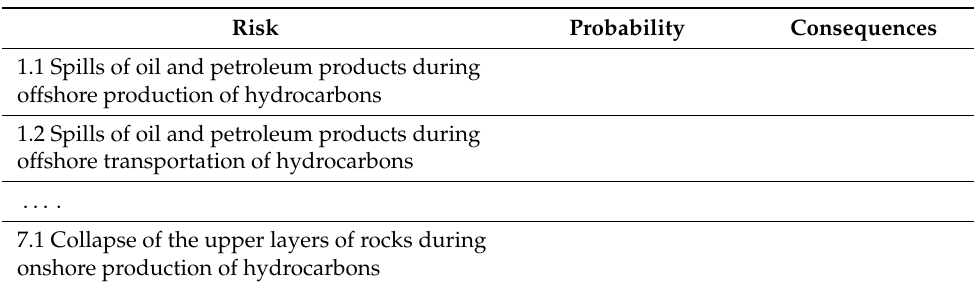
Table A6. List of risks.